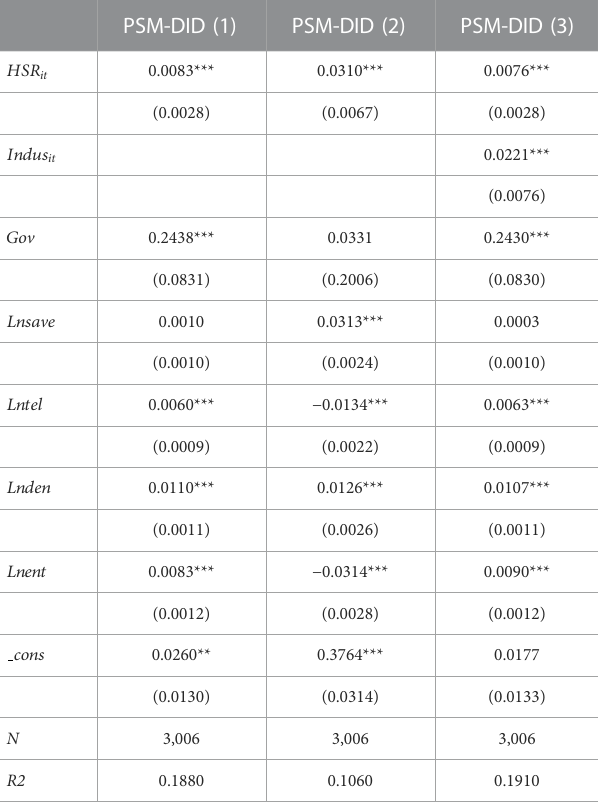
TABLE 15 Mediating effect of industrial